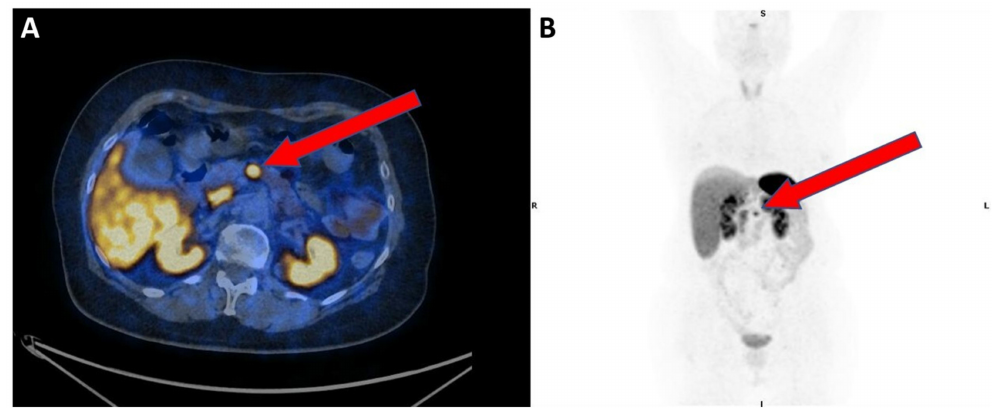
Figure 1. Presurgical [ 68 Ga]Ga-DOTANOC PET / CT transaxial ( A ) and MIP ( B ) show focal and intense uptake in the primary pancreatic lesion (red